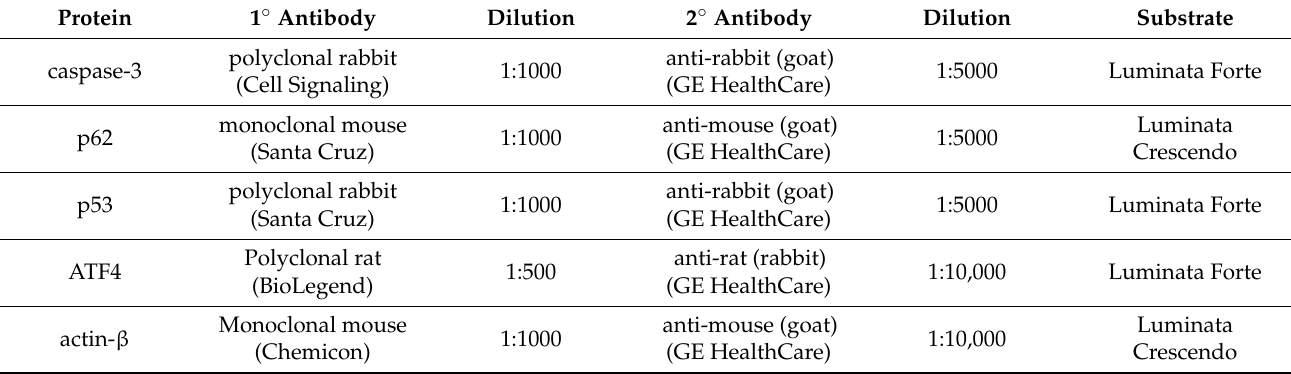
Table 4. Detected proteins, primary and secondary antibodies, relative dilutions and substrates used in this work.